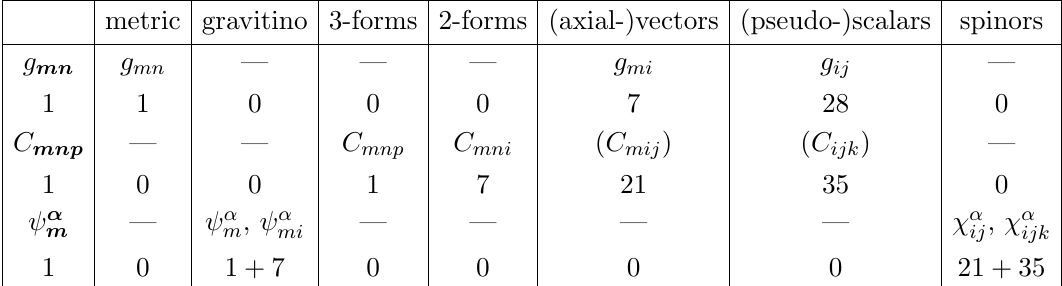
Table 1 . Component spectrum for the 11 ! 4 + 7 split. The reduction of 11D supergravity (cid:12)elds gives rise to a mixture of forms of various degrees. After dualizing axial-vectors and 2-forms, we (cid:12)nd a total of 7 + 21 = 28 vectors, 28 + 7 = 35 scalars, and 35 pseudo-scalars of N = 8 supergravity [13]. The 3-form is non-dynamical on-shell. Axial-vectors and pseudo-scalars are marked with